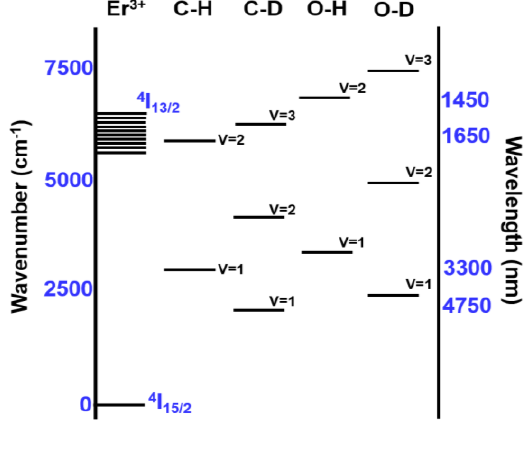
Figure 2. Illustration of energy levels of vibrational modes in hydrogen and deuterium containing organic media. Reprinted/Reproduced with permission from [23]. American Institute of Physics 1974 AIP